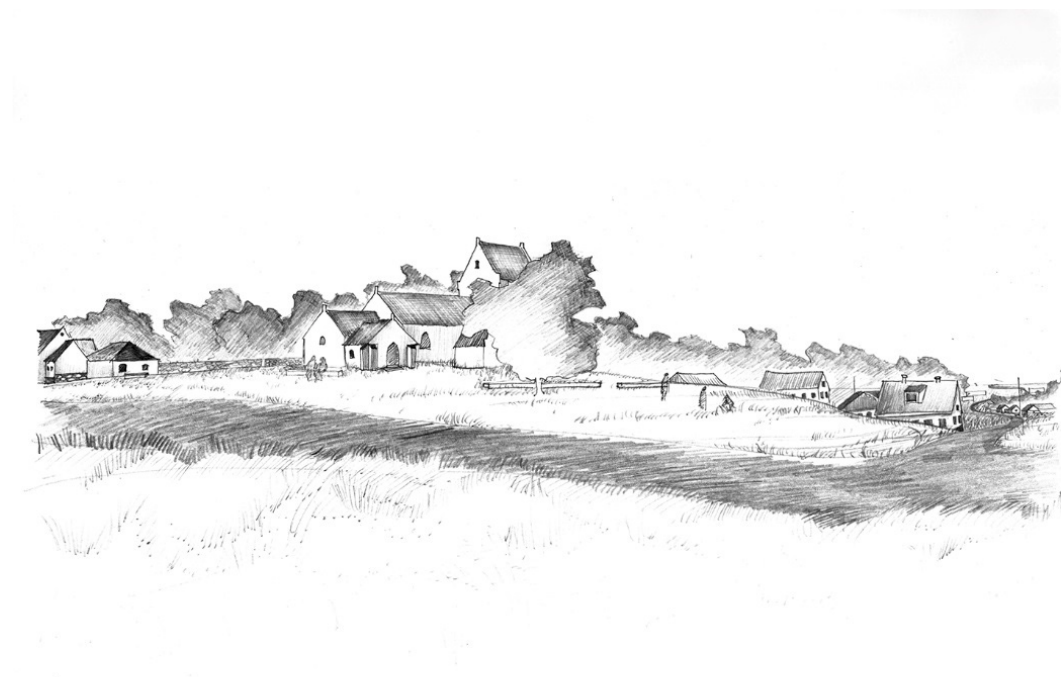
Figure 15. Visualisation of the re-established green in the centre of the village.